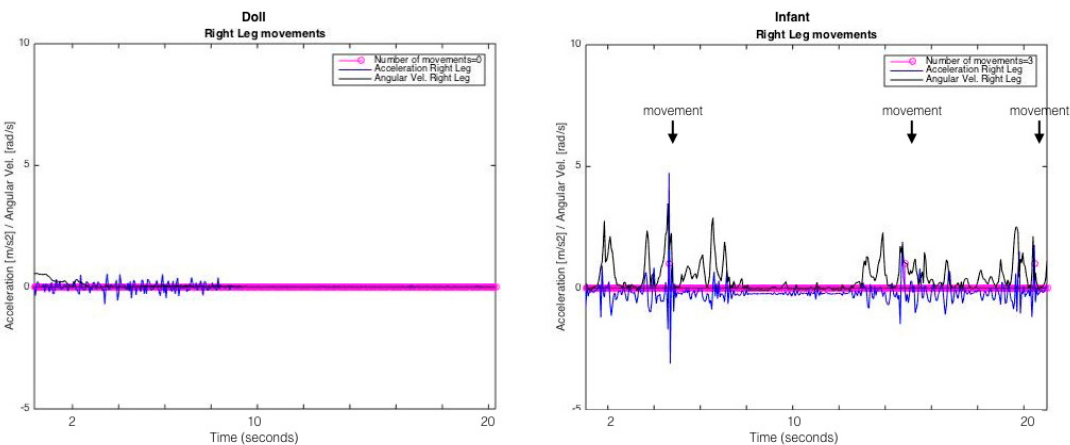
Figure 3. Twenty seconds of analyzed data from the right leg of the doll ( left ) and infant ( right ). The blue line shows resultant acceleration (m / s 2 ) and the black line shows resultant angular velocity (rad / s). These data were recorded when the infant and doll were in the car. No movements were identified for the doll while three movements were identified for the infant (pink circles identified with additional text above the signal). Movements were identified using both acceleration and angular velocity signal thresholds as described in Smith et al., Sensors , 2015 [1].